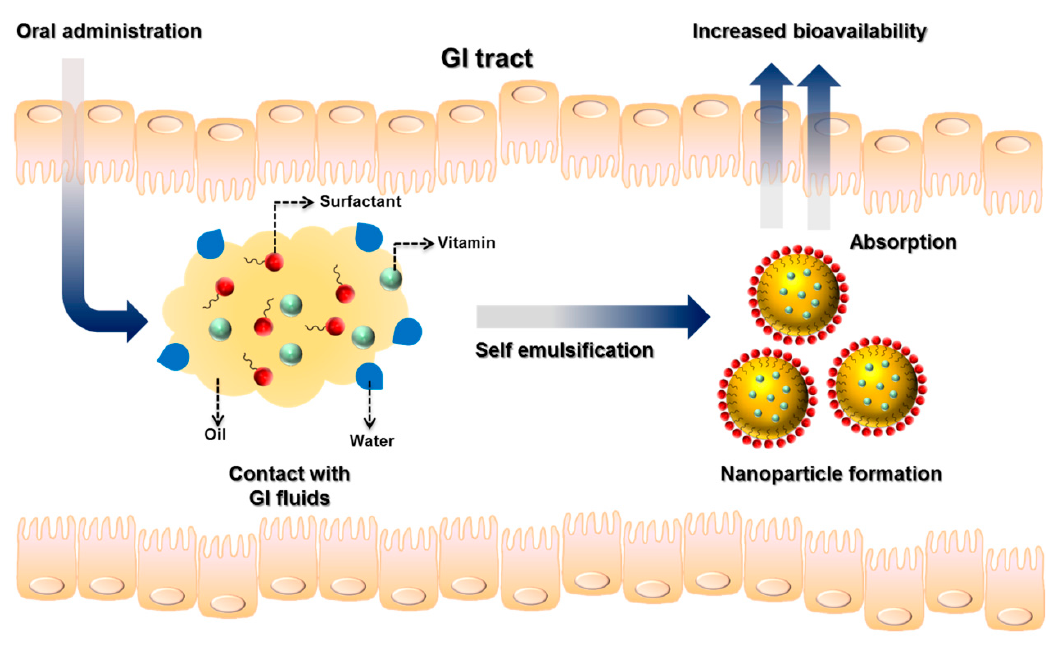
Figure 5. Formation of self-emulsifying drug delivery systems (SEDDSs) in the gastrointestinal tract. The two types of SEDDs are self-nanoemulsifying drug delivery systems (SNEDDSs) and self-microemulsifying drug delivery systems (SMEDDSs). SNEDDSs are generally opaque or